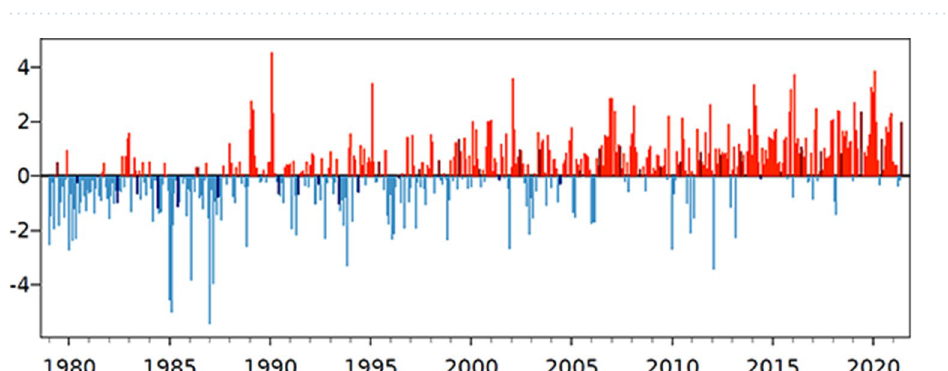
Figure 3. Monthly global temperature anomalies ( ◦ C ).